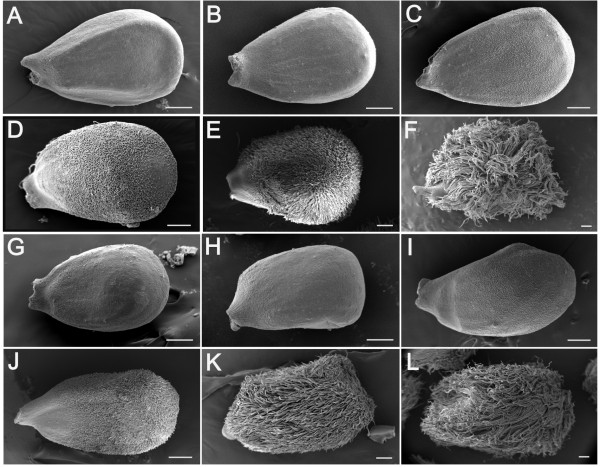
SEM analysis of developing Li2 mutant and WT fibers and ovules. Comparison of (A - F) WT; and Li2 (G - L) mutant fibers and ovules prior to and during fiber initiation and early elongation. The developmental time-points shown are: (A, G) -3 DPA; (B, H) -1 DPA; (C, I) DOA; (D, J) 1 DPA; (E, K) 3 DPA; (F, L) 5 DPA. The scale bars in all panels are 200 μm.